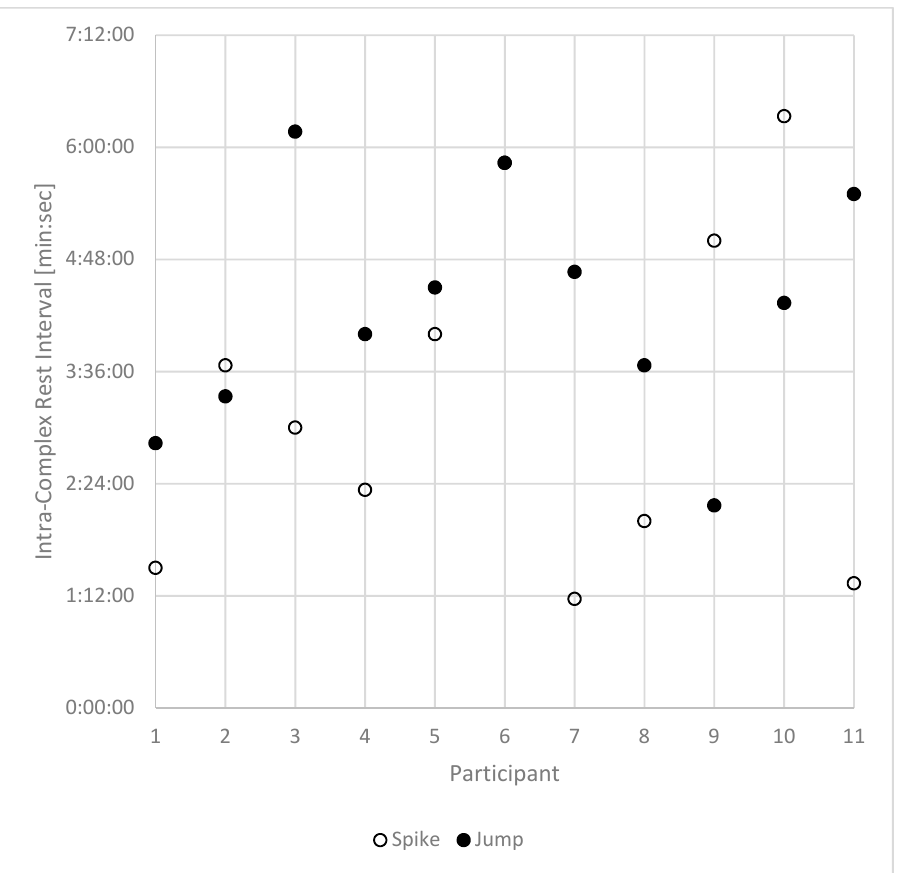
Figure 1. Individual choice of intra-complex rest intervals by the volleyball players participating in the study.